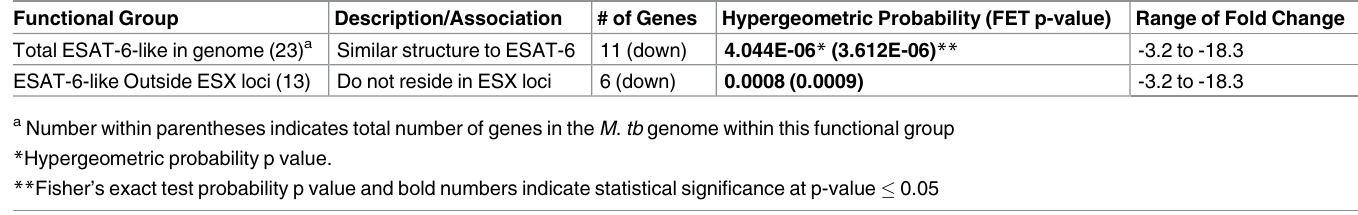
Table 7. Differentially expressedgenes encoding ESAT-6-like